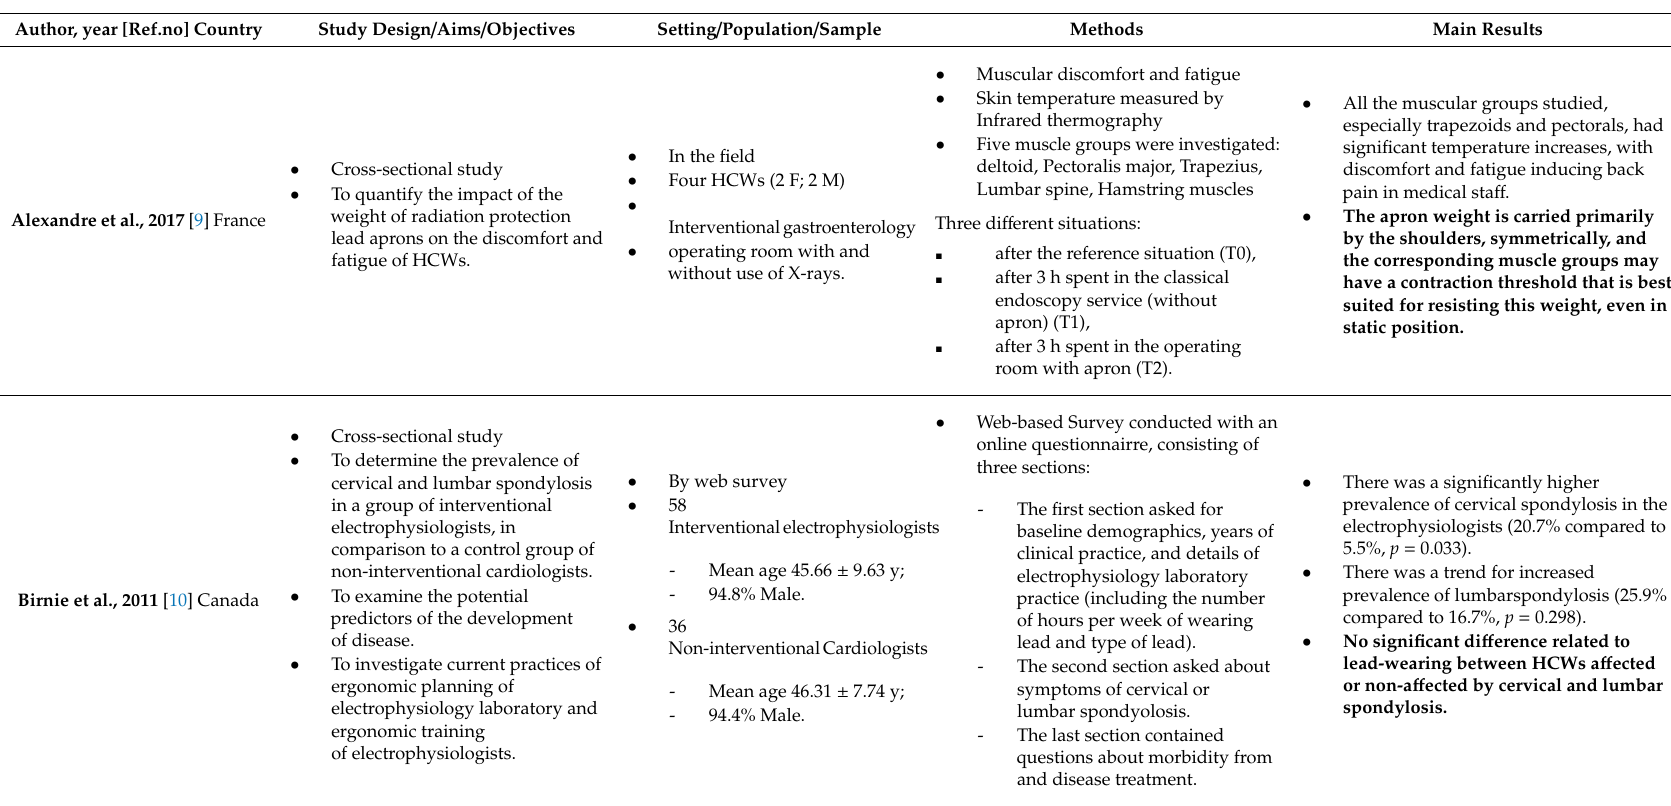
Table 1. Main features and results of the 12 studies included in the scoping review about the correlation between anti-X apron use and musculoskeletal disorders (MSDs) onset. Study conclusions, relating to the topic of this review, are highlighted in bold. Author, year [Ref.no]